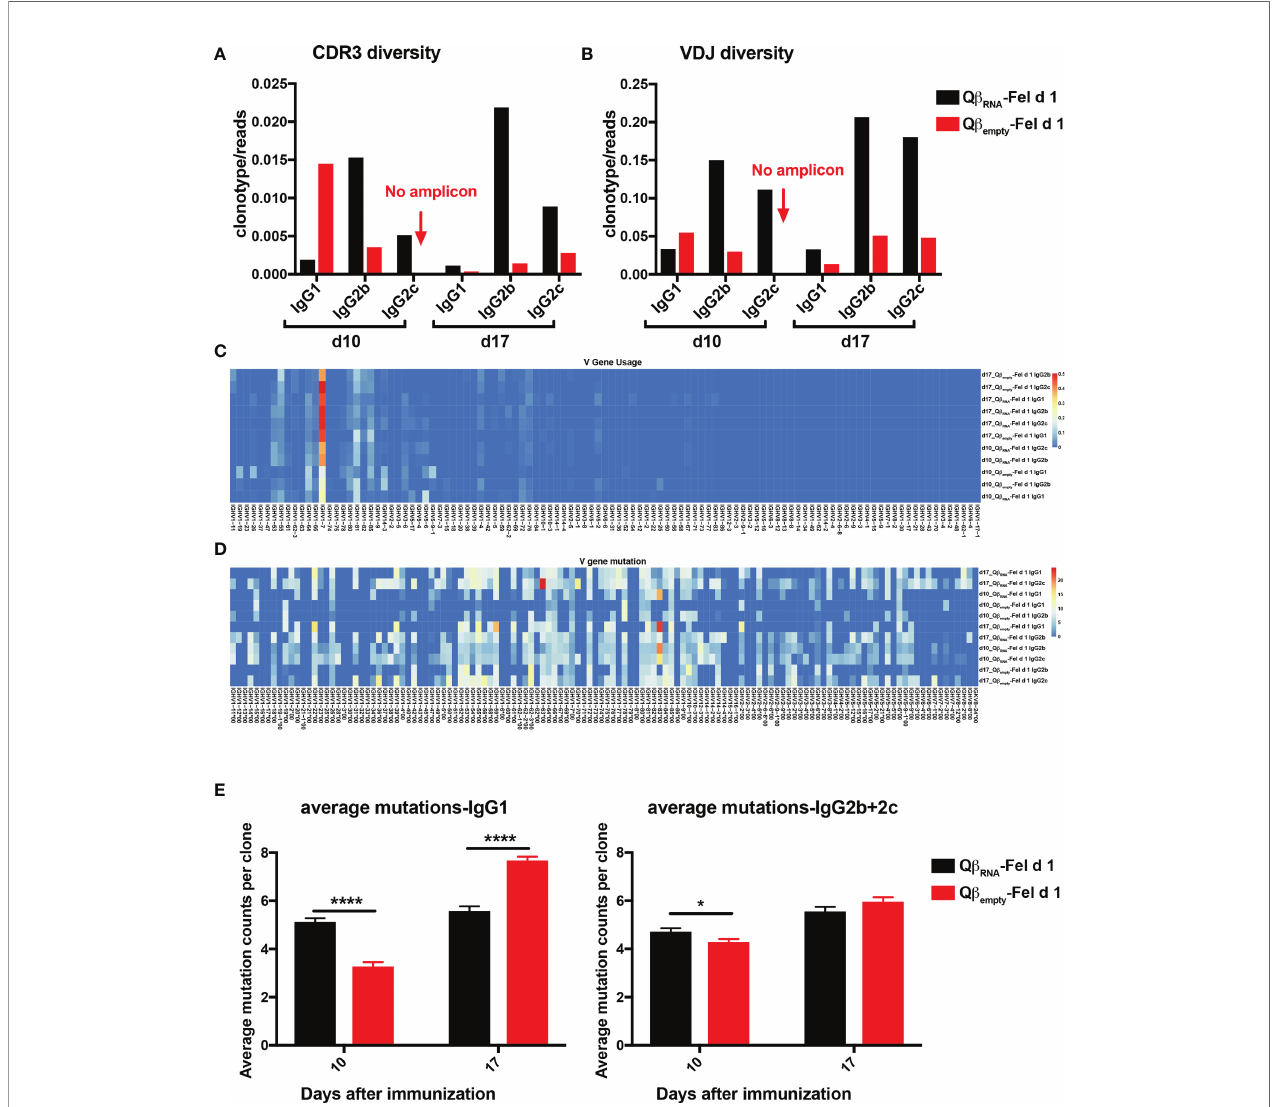
FIGURE 5 | Fel d 1-speci fi c IgG BCR repertoires from Q b RNA -Fel d 1 and Q b empty -Fel d 1 immunized mice. (A, B) Diversity of IgG1, 2b, 2c repertoires in terms of CDR3 sequences (A) and VDJ combinations (B) at d10 and d17 after Q b RNA -Fel d 1 and Q b empty -Fel d 1 immunization. Diversity of each repertoire was determined as the clonotype counts normalized by read counts. (C) Frequency of IGHV gene usage by different repertoires. (D) Mutation frequency on germline IGHV sequences in Fel d 1-speci fi c BCR repertoires; (E) Average mutations of IgG1 and IgG2b+2c repertoires at different time points after Q b RNA -Fel d 1 and Q b empty -Fel d 1 immunization. p value from unpaired t-test was indicated as ≤ 0.05 (*), ≤ 0.001 (***). The fi gure is representative of two independent